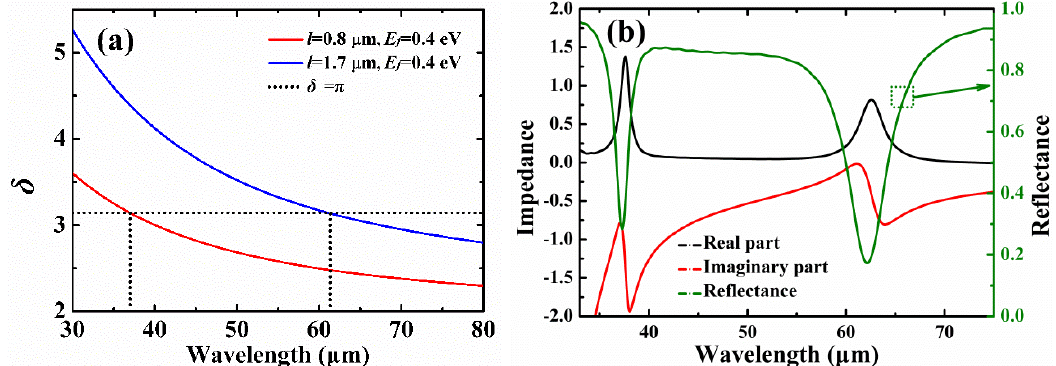
Figure 4. ( a ) Resonance wavelengths estimated by using the F-P cavity model for different cavity lengths with E f = 0.4 eV. ( b ) Reflection response and input impedance of the cross-shaped graphene arrays.